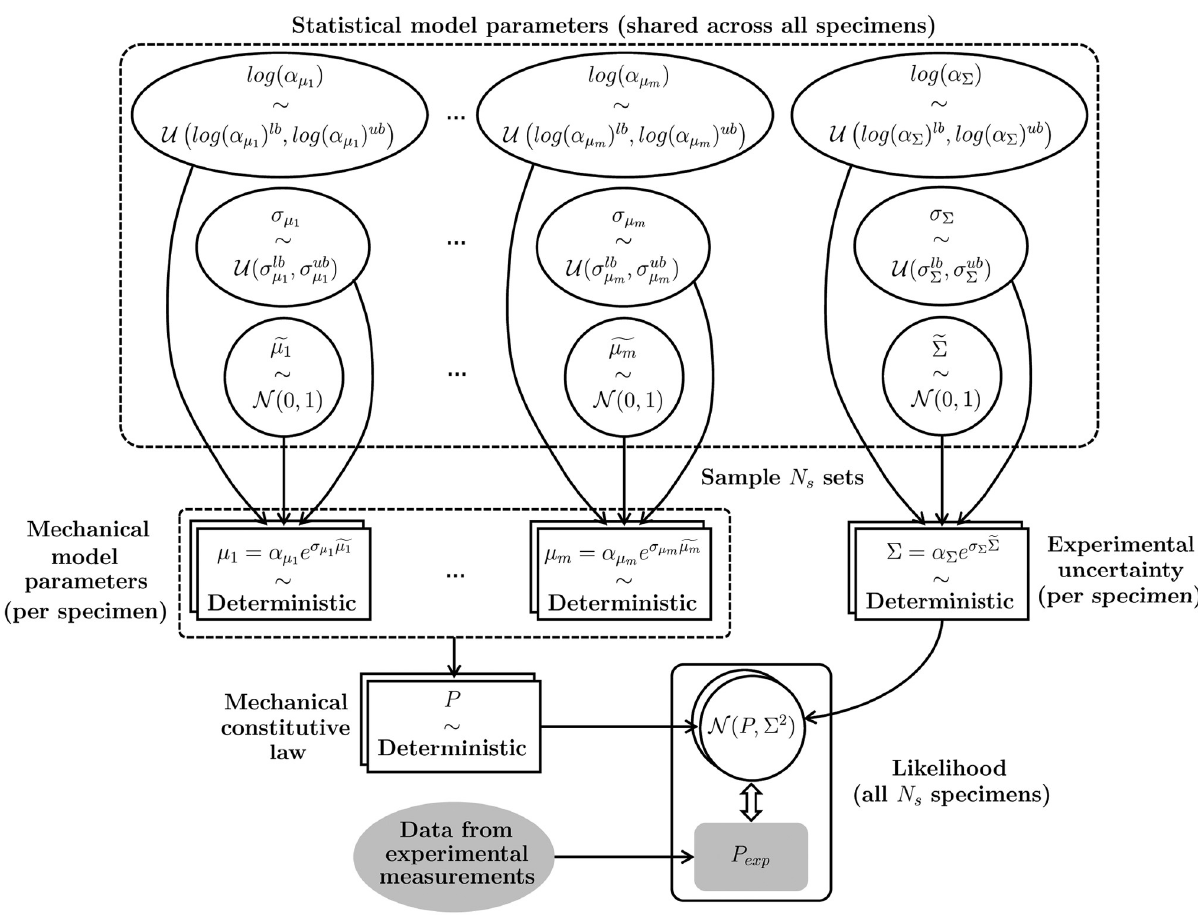
Fig 2. Schematic of the hierarchical Bayesian model posed to capture the experimentally-measured mechanical response of a set of N s inter- related tissue specimens. A set of 3( m + 1) hyperdistributions, common across all specimens, generates the mN mechanical model parameters s corresponding to each tested specimen, and the N parameters representing experimental uncertainty. These parameters yield deterministic predictions s for the mechanical behavior of each specimen, which are to be compared to the corresponding experimental evidence in order to establish a best-fitting set of